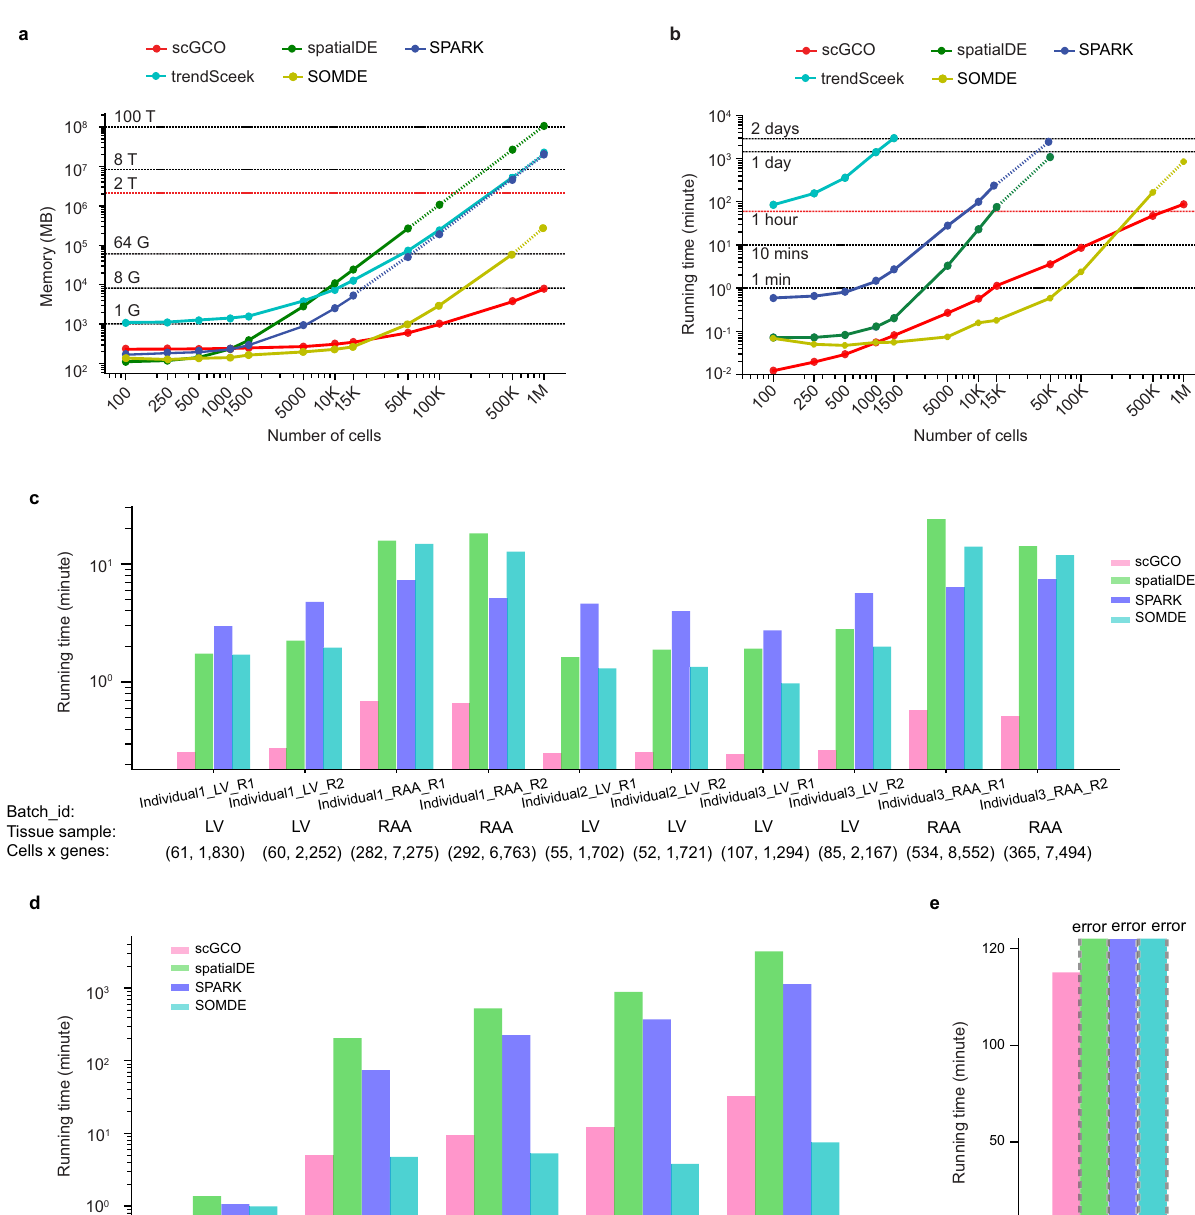
Tissue sample: Cells x genes: